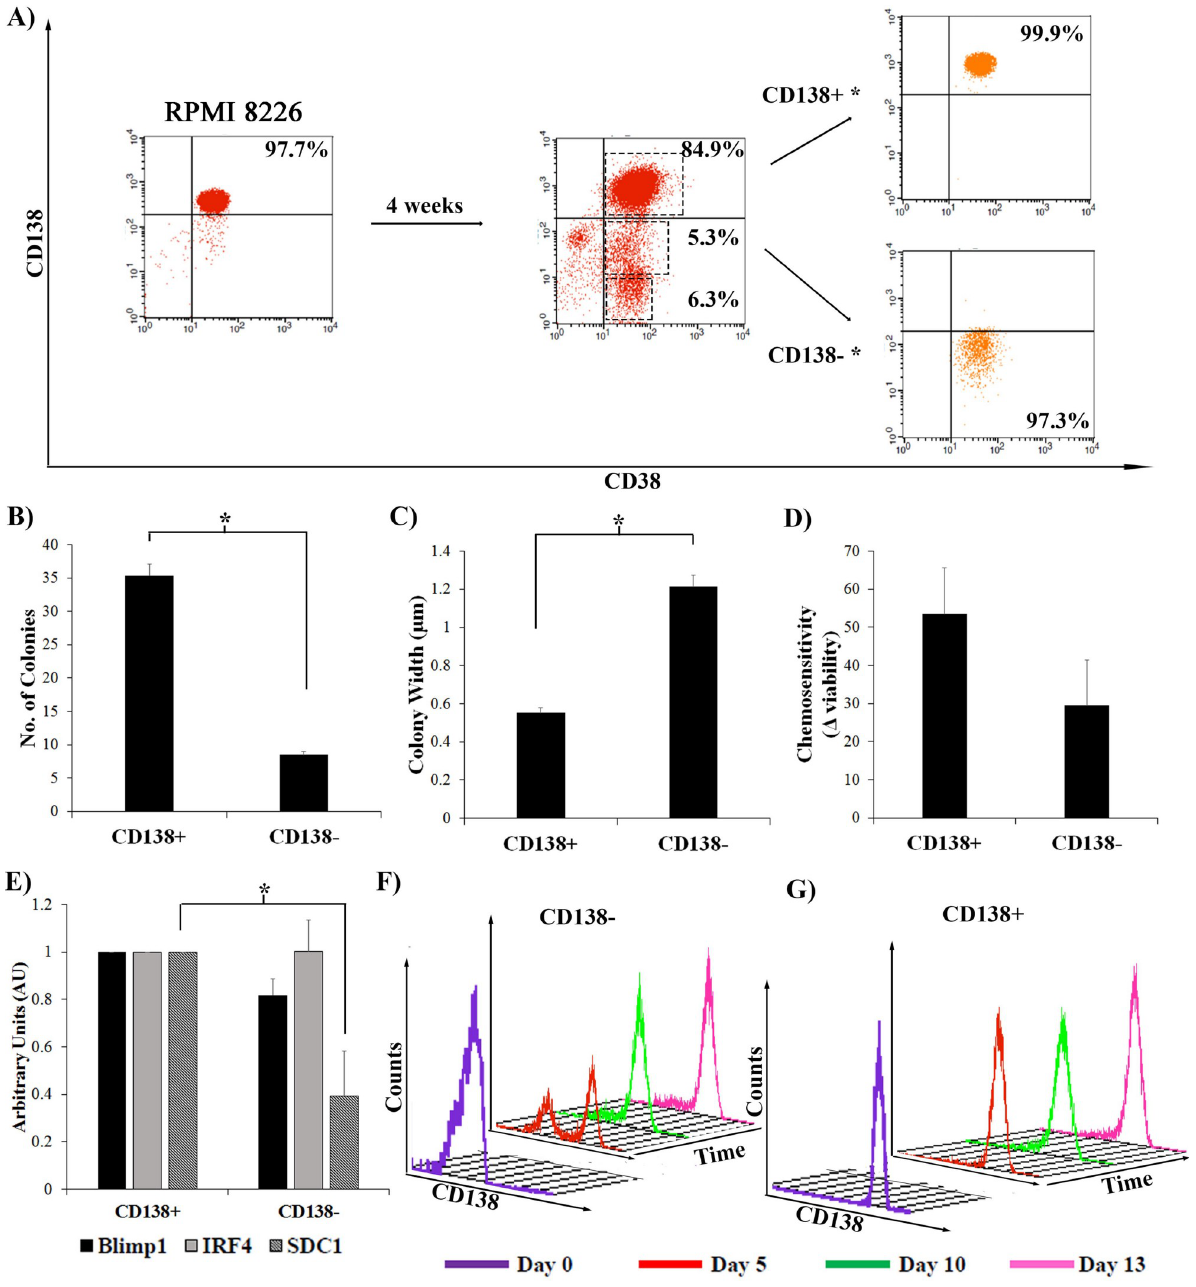
Fig 3. Authenticity of newly dedifferentiated RPMI 8226 CD138- cells. A) Sorted CD138+CD38+ populations were plated for four weeks, and then re-sorted based on CD138 status, to yield newly differentiated CD138+ � and dedifferentiated CD138- � populations. Representative of N = 3. Dashed boxes is non-viable (population iii). B,C) These sorted CD138+ � and CD138- � cells were plated in methylcellulose, colonies were counted and measured (N = 3) � p < 0.05. D) CD138+ � and CD138- � cells were plated and treated with Bortezomib for 24 h. Chemosensitivity was measured as the difference in viability before and after treatment (N = 3). E) RT-PCR on CD138+ � and CD138- � populations to assess the levels of Blimp1, IRF4, and SDC1 (CD138) (N = 3). The levels seen in CD138+ cells was set to 100, plotted as AU, � p < 0.05. Error bars, mean ± SD. F,G) Sorted CD138+ � and CD138- � populations were plated, and analyzed for CD138 by flow cytometry at days 5, 10, and 13. Purple line is CD138 content at time of plating (Representative of N = 3).